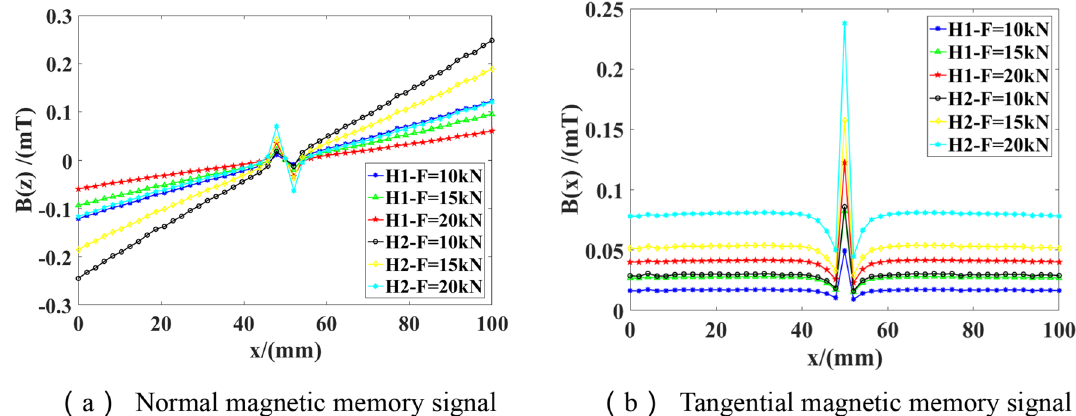
Fig. 11 Magnetic memory signal changes under different pulling forces in excitation magnetic field environment. a Normal magnetic mem- ory signal. b Tangential magnetic memory signal